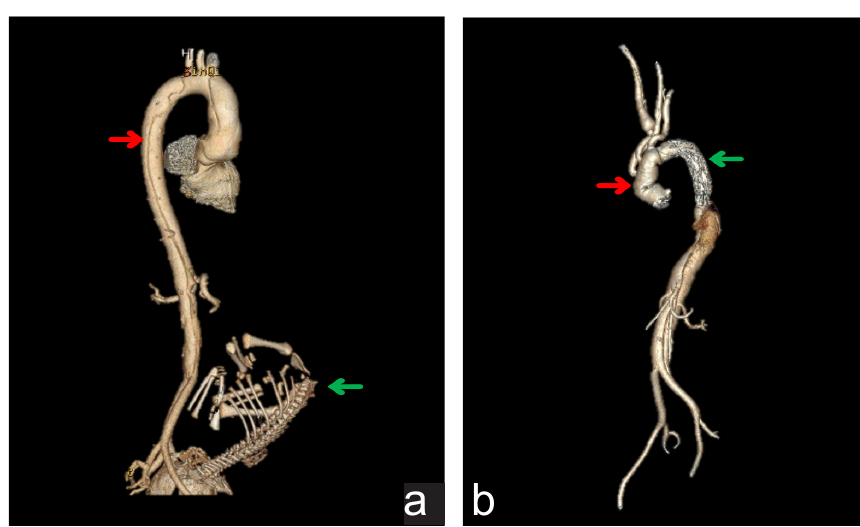
Fig. 2 - Changes in pre- and postoperative computed tomography angiography images of Case 2. (A) 3D reconstruction of preoperative CT images shows the location of thoracoabdominal aorta dissection marked by a red arrow and the fetal skeleton marked by a green arrow. (B) 3D reconstruction of postoperative CT images shows the artificial blood vessel marked by a red arrow and the covered stent graft marked by a green